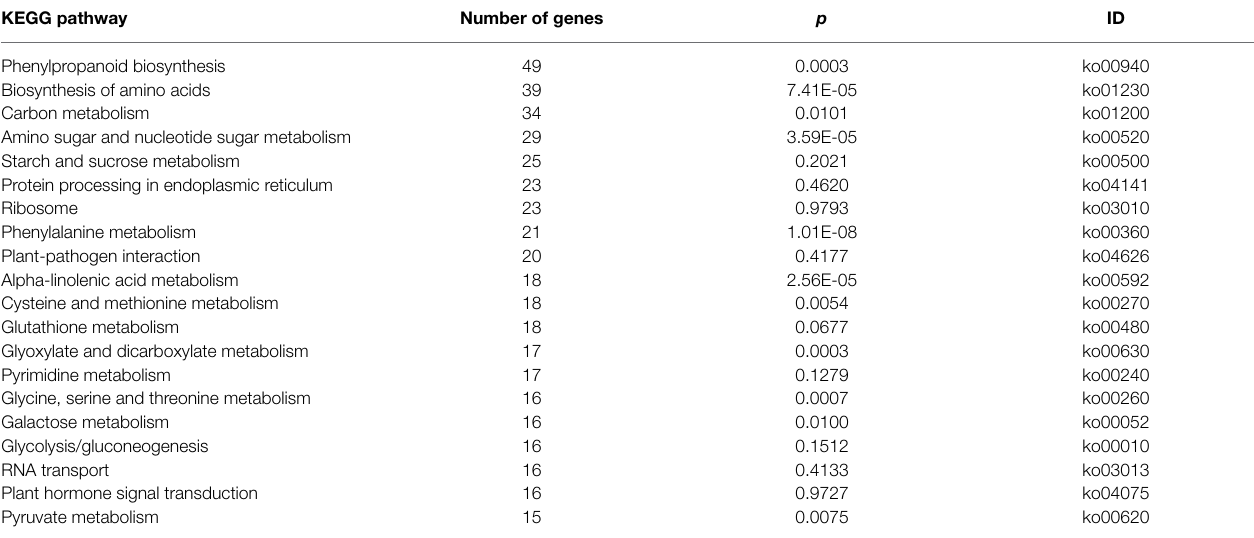
TABLE 3 | Kyoto Encyclopedia of Genes and Genomes (KEGG) pathways significantly enriched in DEGs. KEGG